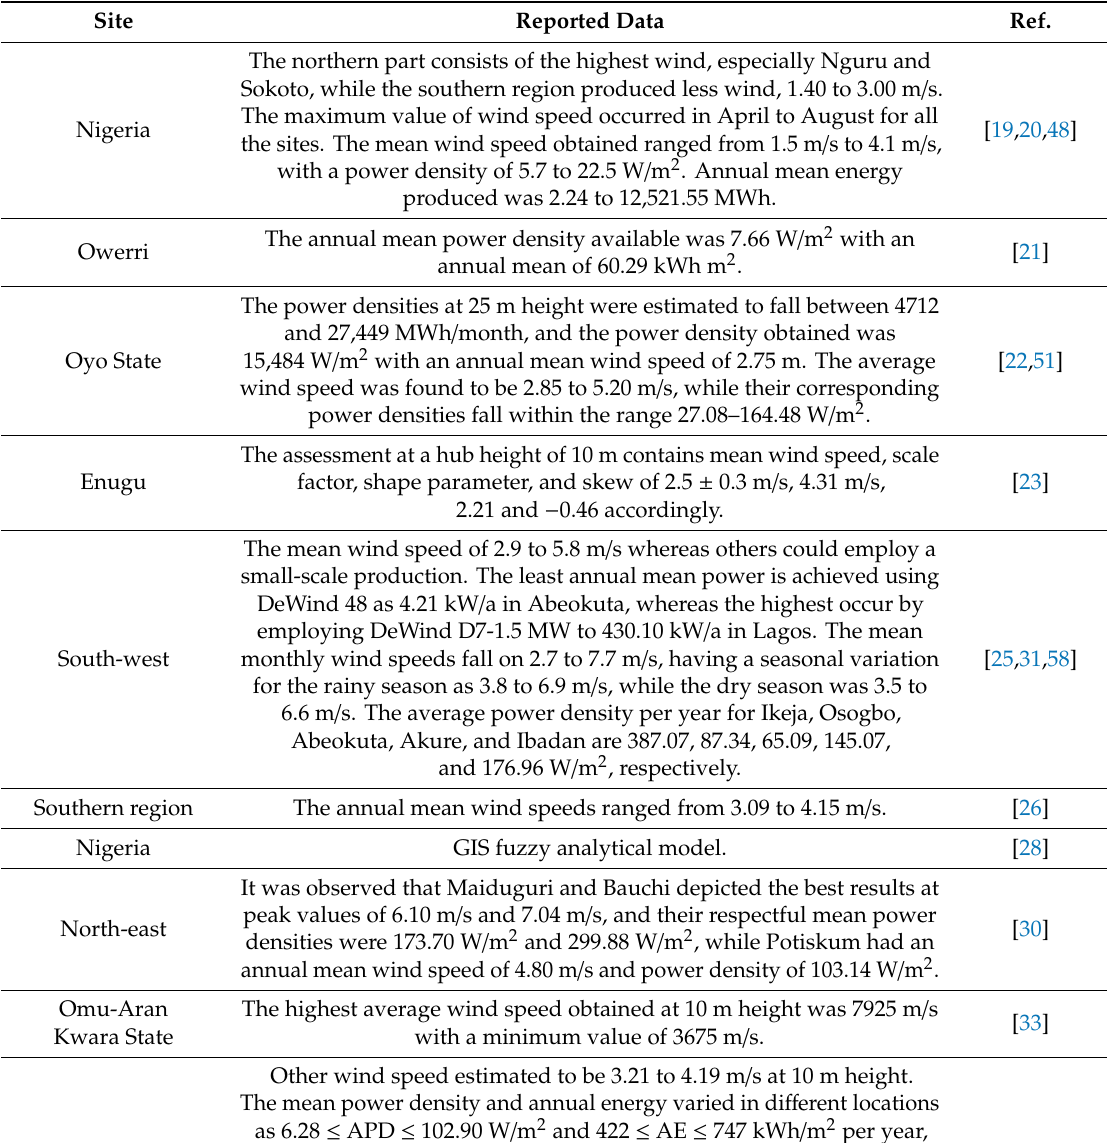
Table 1. The data summary of assessment of wind energy